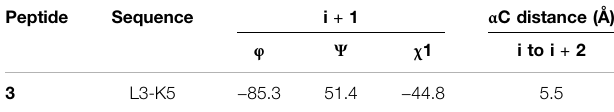
TABLE 6 | Mean values of φ , ψ , and χ 1 angles and α C distances relative to the most representative conformers of 3 . Peptide